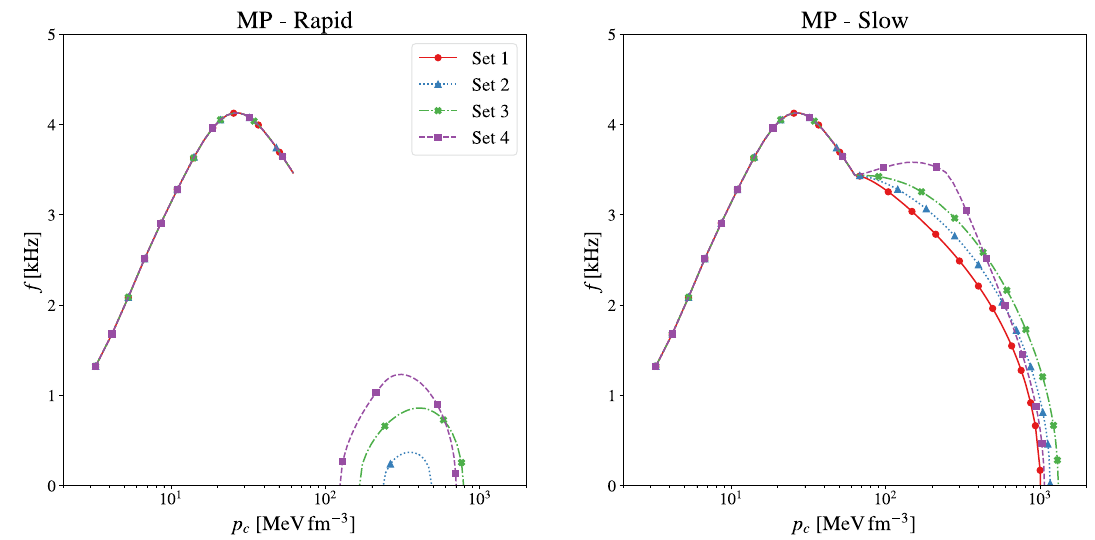
Fig. 4 Predictions for the fundamental linear eigenfrequency as a function of central pressure for neutral twin stars, considering rapid (left panel) and slow (right panel) conversions and the distinct sets of the MP approach for the QM EoS